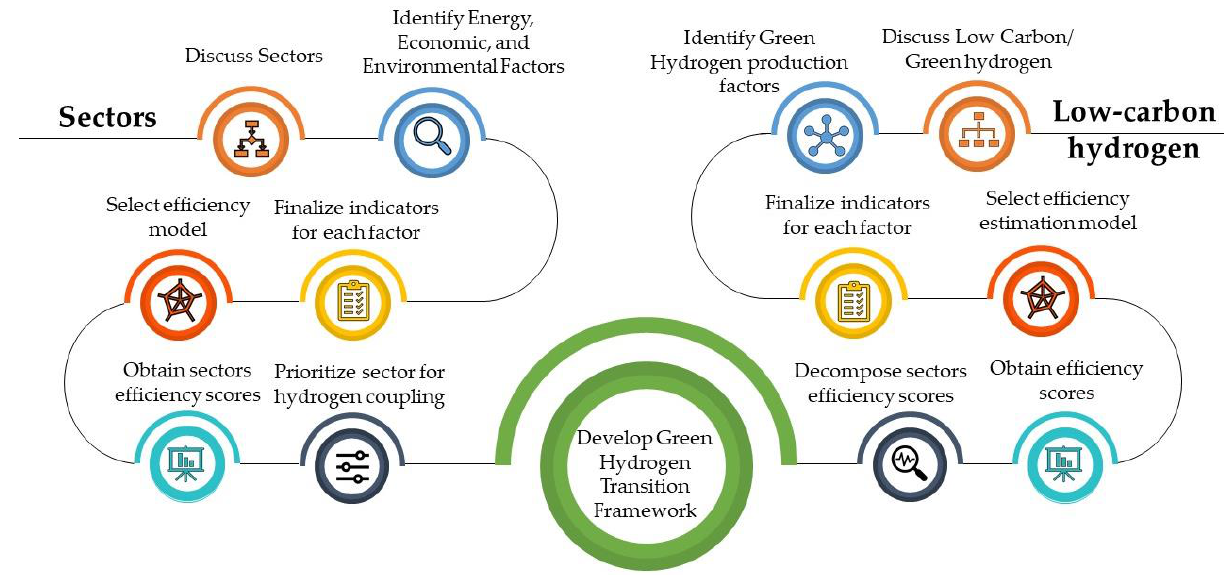
Figure 1. Research overview.